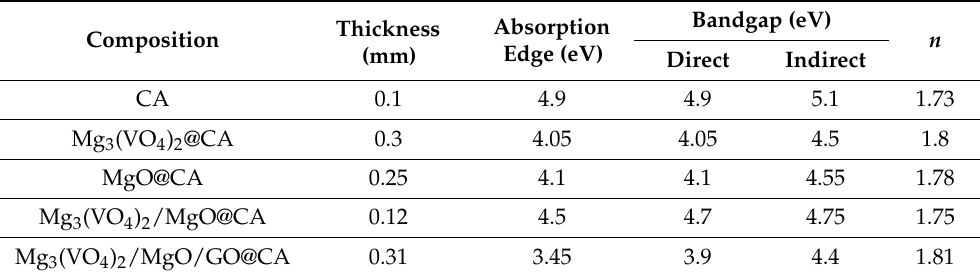
Figure 8. Optical behavior of the CA-based films. Table 2. Optical properties of CA-based nano-films, including absorption edge, direct and indirect bandgaps, and refractive index ( n ).